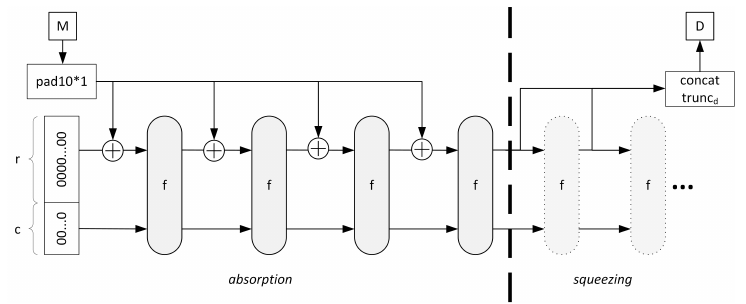
Figure 6. Sponge construction, which is the basis of SHA-3. Table 2. Capacity c and rate r of SHA-3 algorithms in relation to hash